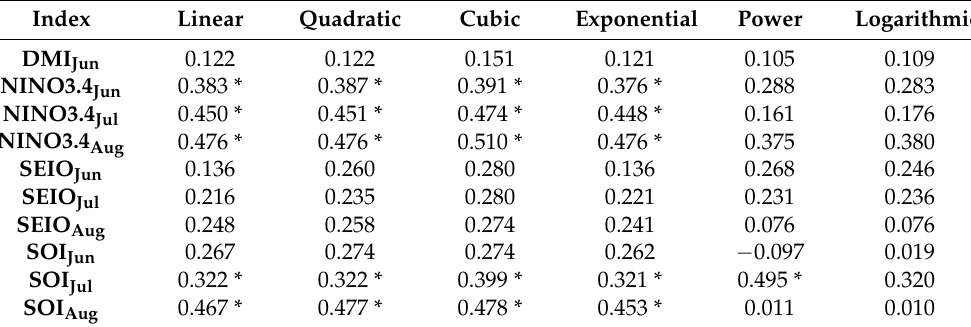
Table 3. Pearson correlations of the regression analysis for Huntly